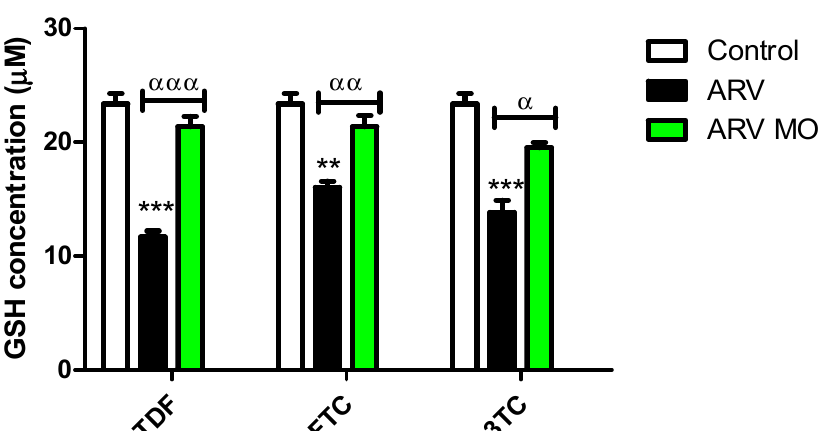
Figure 4. Assessment of GSH concentration post-ARV and post-ARV MO treatment. TDF, FTC, and 3TC significantly decreased the levels of intracellular GSH, while ARV MO displayed a significant increase in GSH in HepG2 cells. * Represents a significant difference between the control and ARV (**, p < 0.001 and ***, p < 0.0001). α Represents a significant difference between ARV and ARV MO